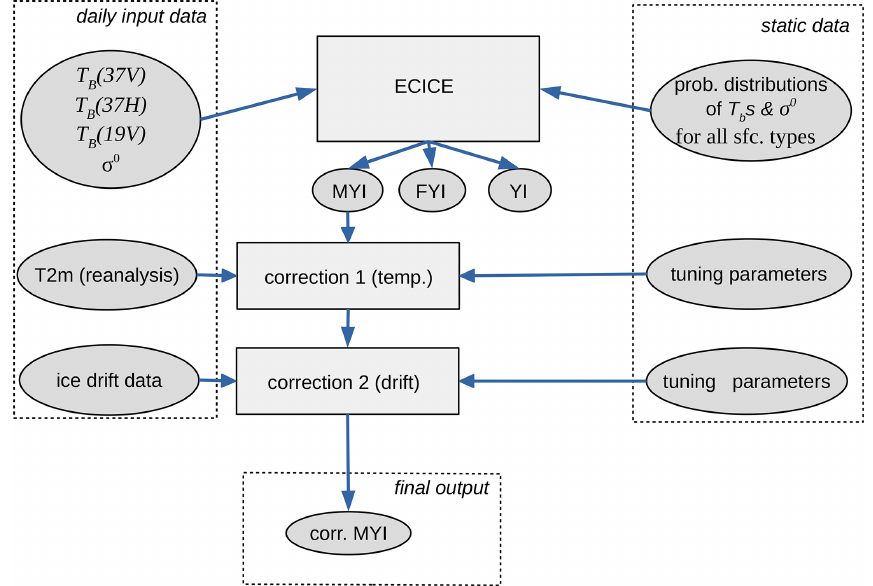
Figure 1. Flowchart of ECICE and the two correction schemes as well as the different types of input data. Note: prob. is probability; sfc. is